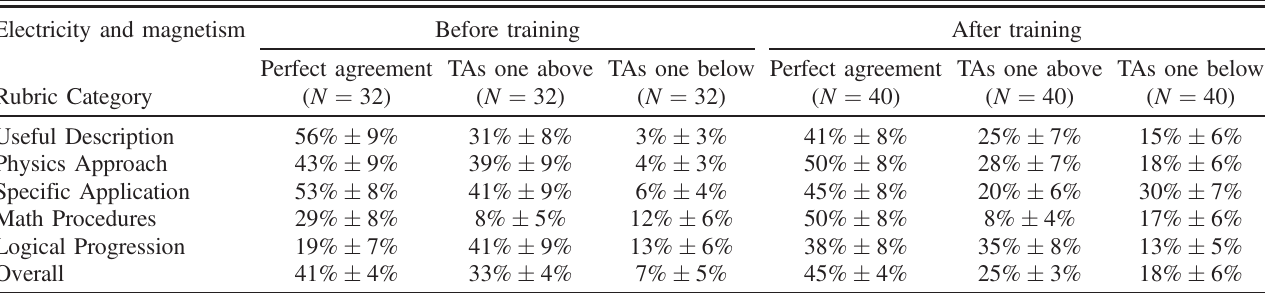
TABLE VII. Percent agreement of third-year graduate student scores with rubric developer scores averaged over all problems before and after training (electricity and magnetism problems). The combined agreement within one score is 81 % (cid:2) 2 % before training and 88 % (cid:2) 2 % after training. N is the number of problems scored by the participants in the group ( 4 raters× 8 problems before training; 4 raters× 10 problems after